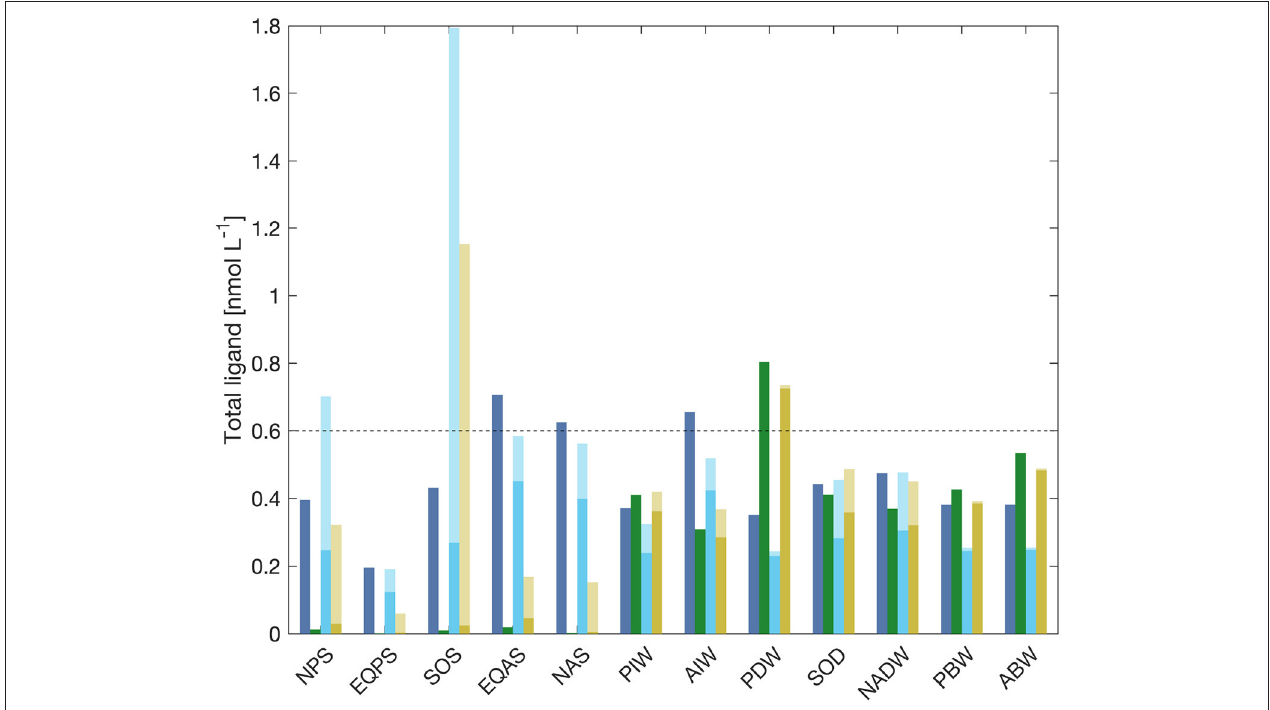
FIGURE 5 | Equilibrium ligand concentrations in all model boxes for the model with one prognostic ligand (blue, run 1L ), with one long-lived ligand (green, run 1H ) and for the model runs with two prognostic ligands (cyan, run 2L , and yellow, run 2H ). In the latter two, the lighter color stands for the siderophore-like ligand S i , while the darker stands for the longer-lived ligand L i . The dashed line shows the constant ligand concentration in run CL .